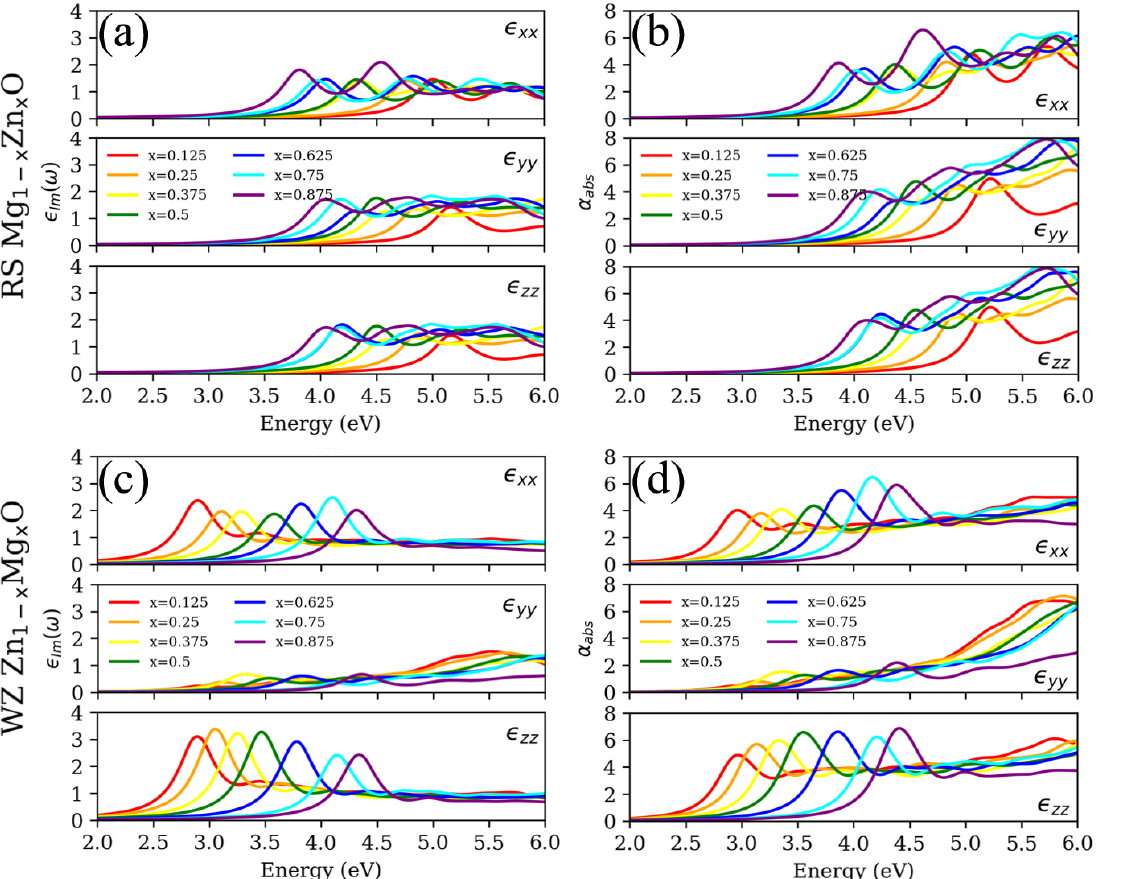
Figure 7. ( a , c ) Imaginary part of the dielectric function ( (cid:101) Im ) and ( b , d ) absorption coefficient ( α abs ) for rocksalt (RS) Mg 1 − x Zn x O and wurtzite (WZ) Zn 1 − x Mg x O based on Bethe–Salpeter equation. The symbols, colors and legends are identical to the descriptions in Figure